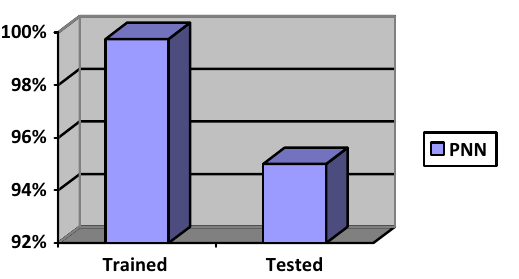
Fig. 4 Comparison of trained and tested dataset classification using probabilistic neural